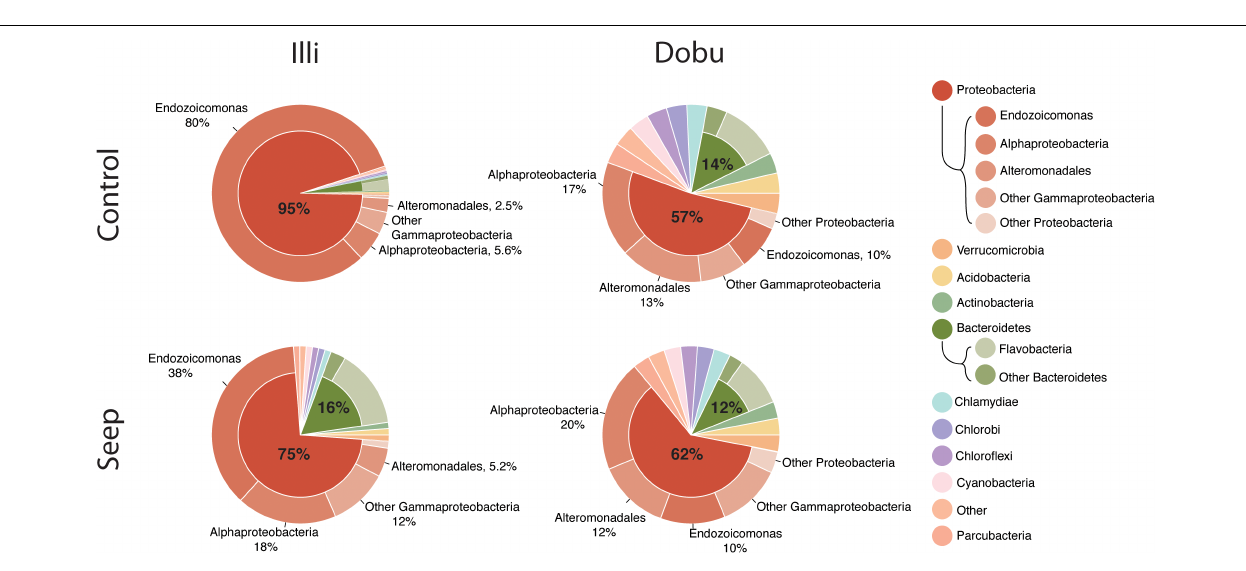
FIGURE 4 | Ten most abundant microbial phyla associated with massive Porites. “ Other” represents all microbes not in the top 10. The two most abundant phyla, Proteobacteria and Bacteroidetes , are split further into classes. Gammaproteobacteria are split further to illustrate the high relative abundance of the genus Endozoicomonas (outside ring). Percentages are mean proportion of total